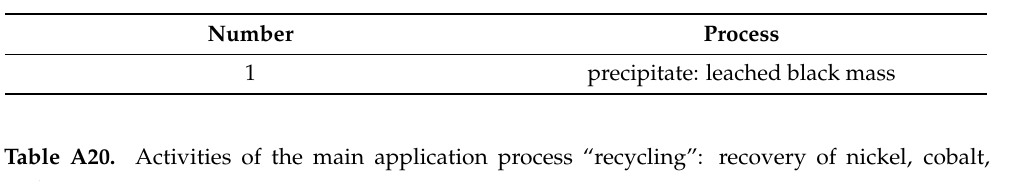
Table A19. Activities of the main application process “recycling”: remove contaminants.